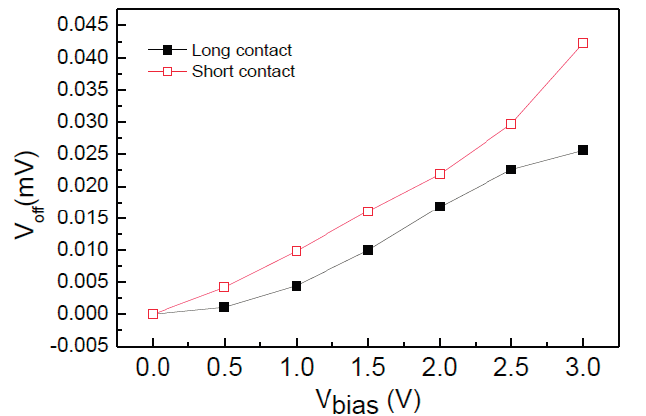
Figure 2. Offset voltage comparison of long-contact and short-contact Hall plates.